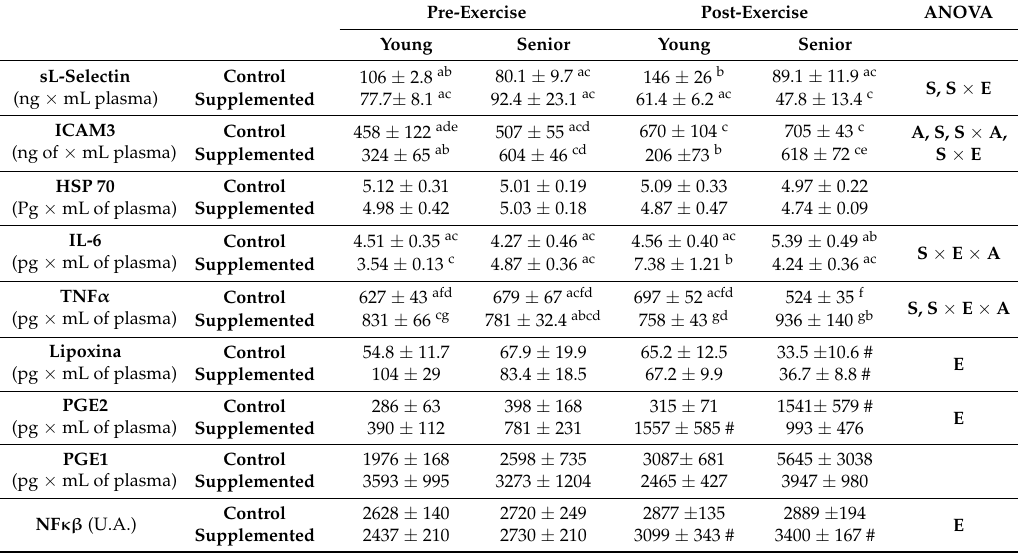
Table 5. Age, dietary beverage supplementation and acute exercise effects on markers of inflammation and heat stress in plasma and inflammatory priming of peripheral blood mononuclear cells.